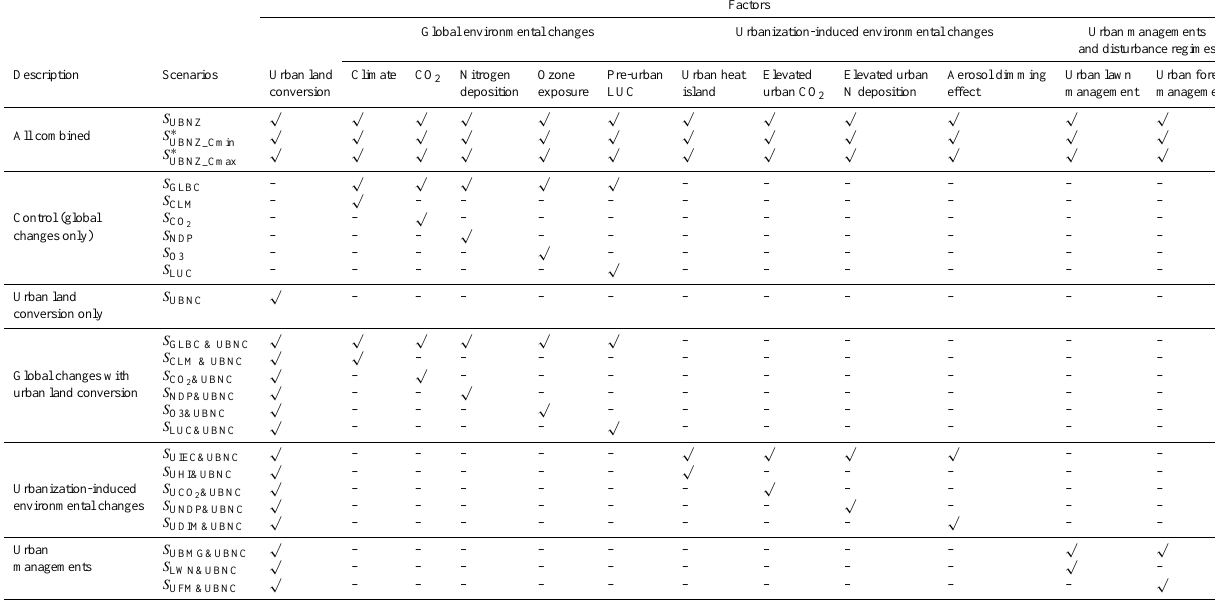
Table 1. Scenario design for numeric experiments and factorial